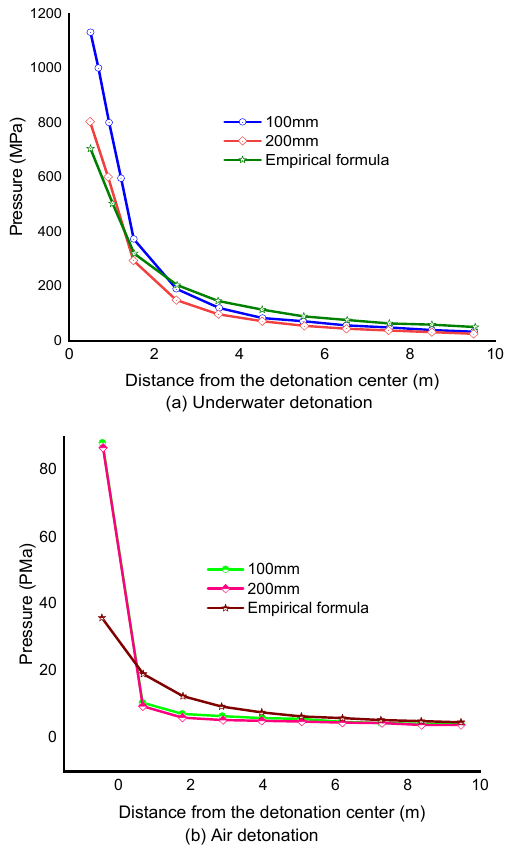
Mesh sizes of 100 and 200 mm were used for the 3D free-field underwater model and the air explosion model, respectively, to assess the mesh size effect of the 3D model. To